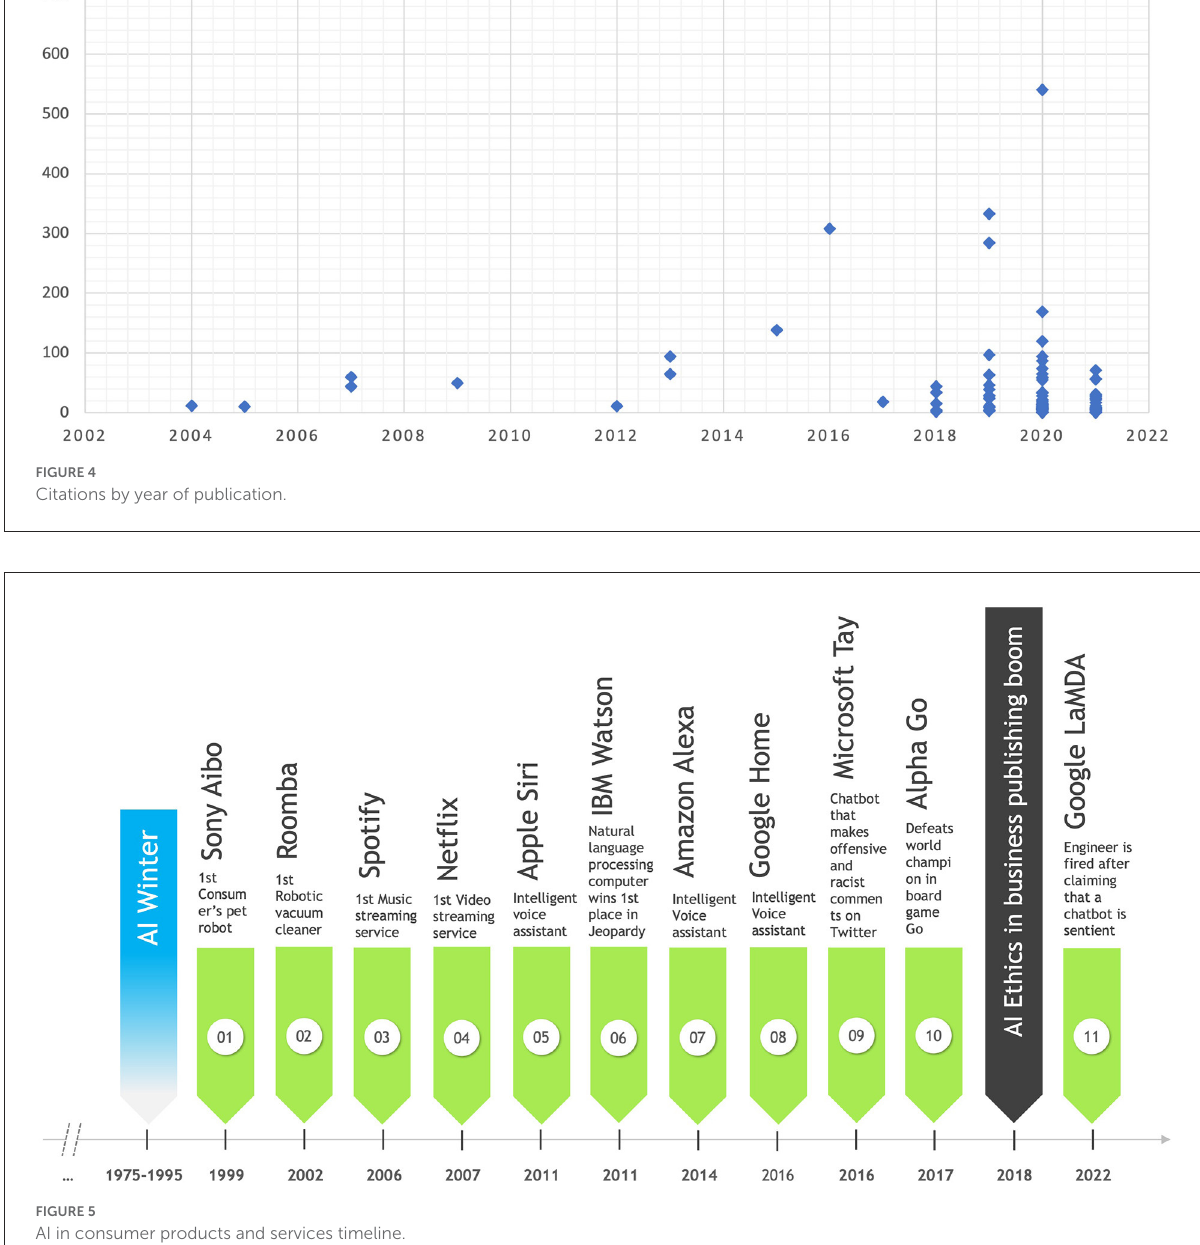
FIGURE5 AI in consumer products and services